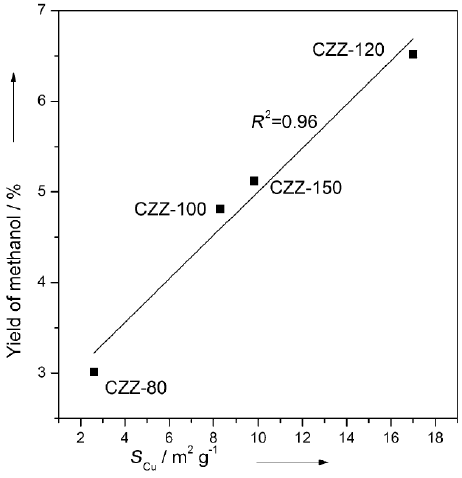
Figure 2. Linear relation between the CH 3 OH % yield and the surface of Cu particles (S Cu ). Reprinted from Huang, C.; Mao, D.; Guo, X.; Yu, J., Microwave-Assisted Hydrothermal Synthesis of